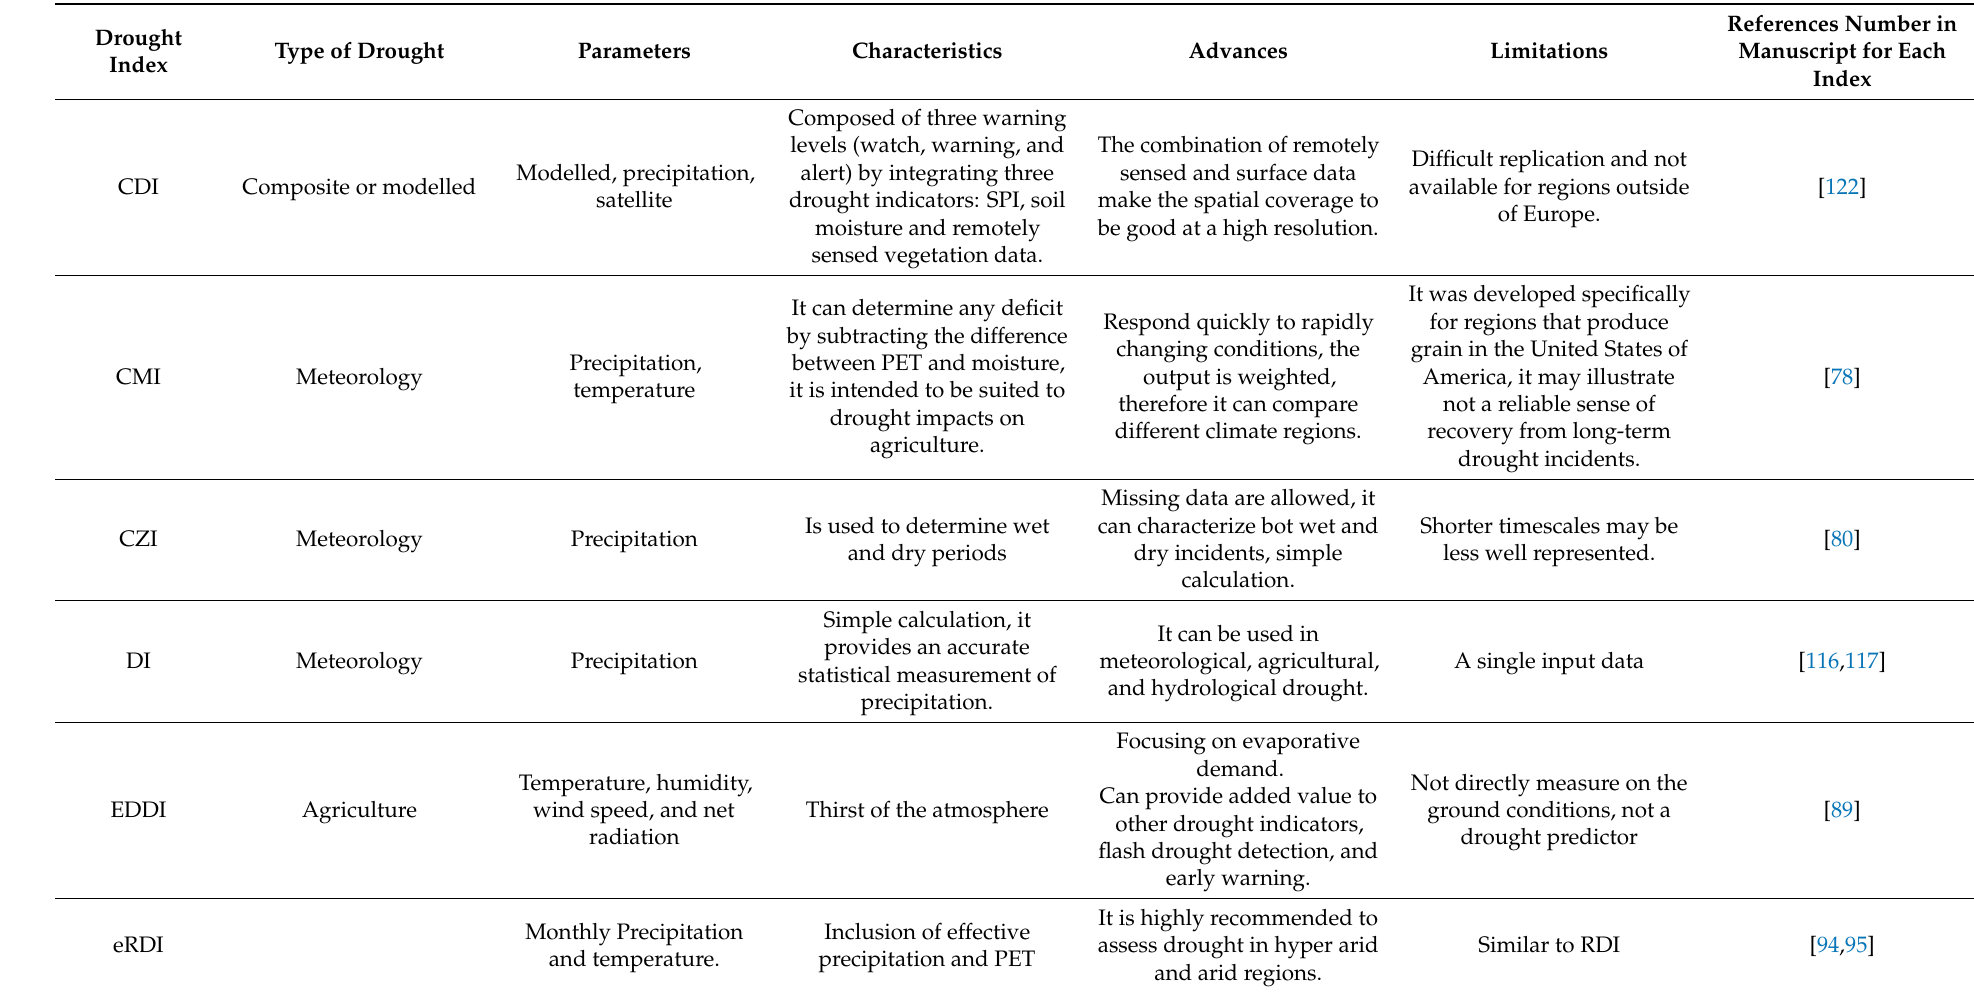
Table 1. The effectiveness of drought indices that are referenced in this